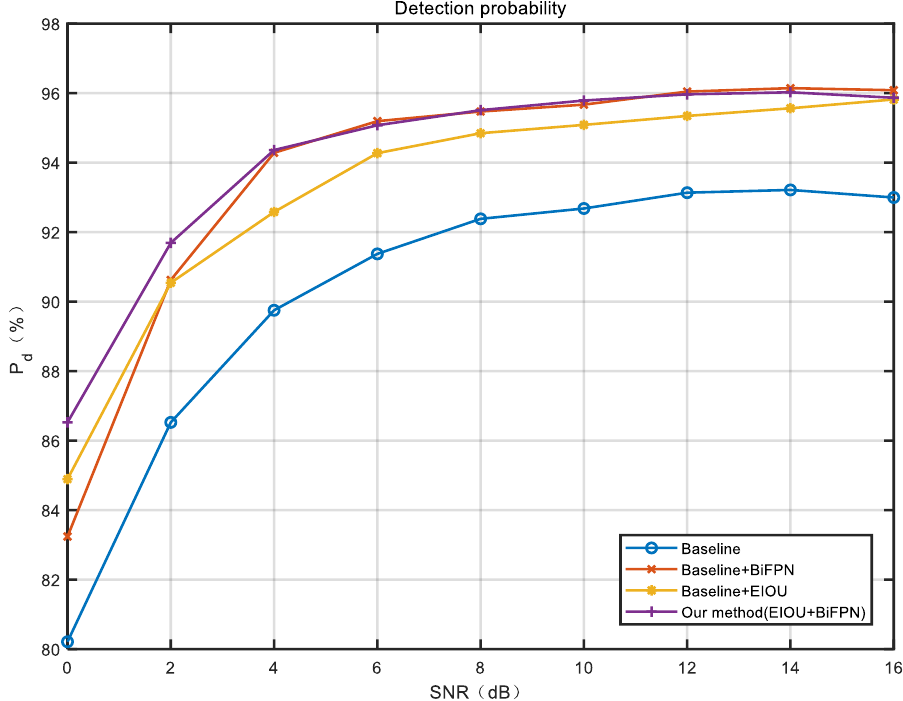
Figure 11. Experimental results of detection probability under different signal-to-noise